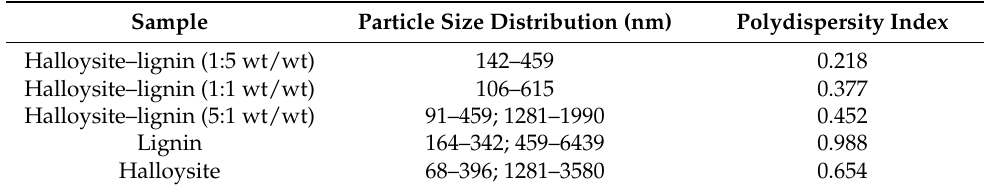
Table 2. Particle size distributions and polydispersity indexes for halloysite–lignin hybrid materials and pristine components (lignin and